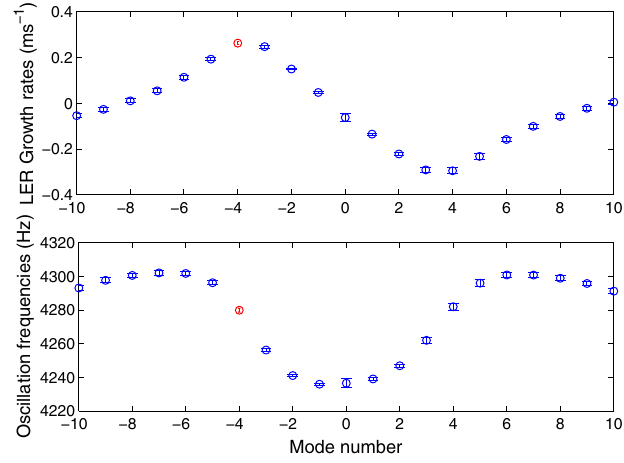
FIG. 9. (Color) Modes (cid:1) 10 to 10 for the nominal case.